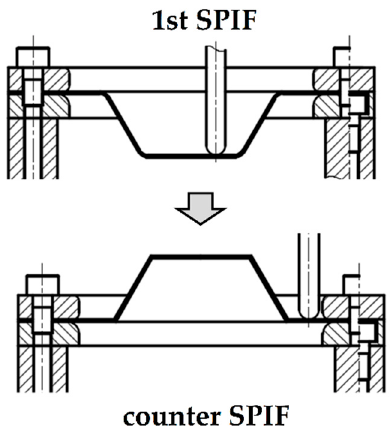
Figure 2. Schematic drawing of the conventional incremental forming process and the counter forming process to decrease shape error.